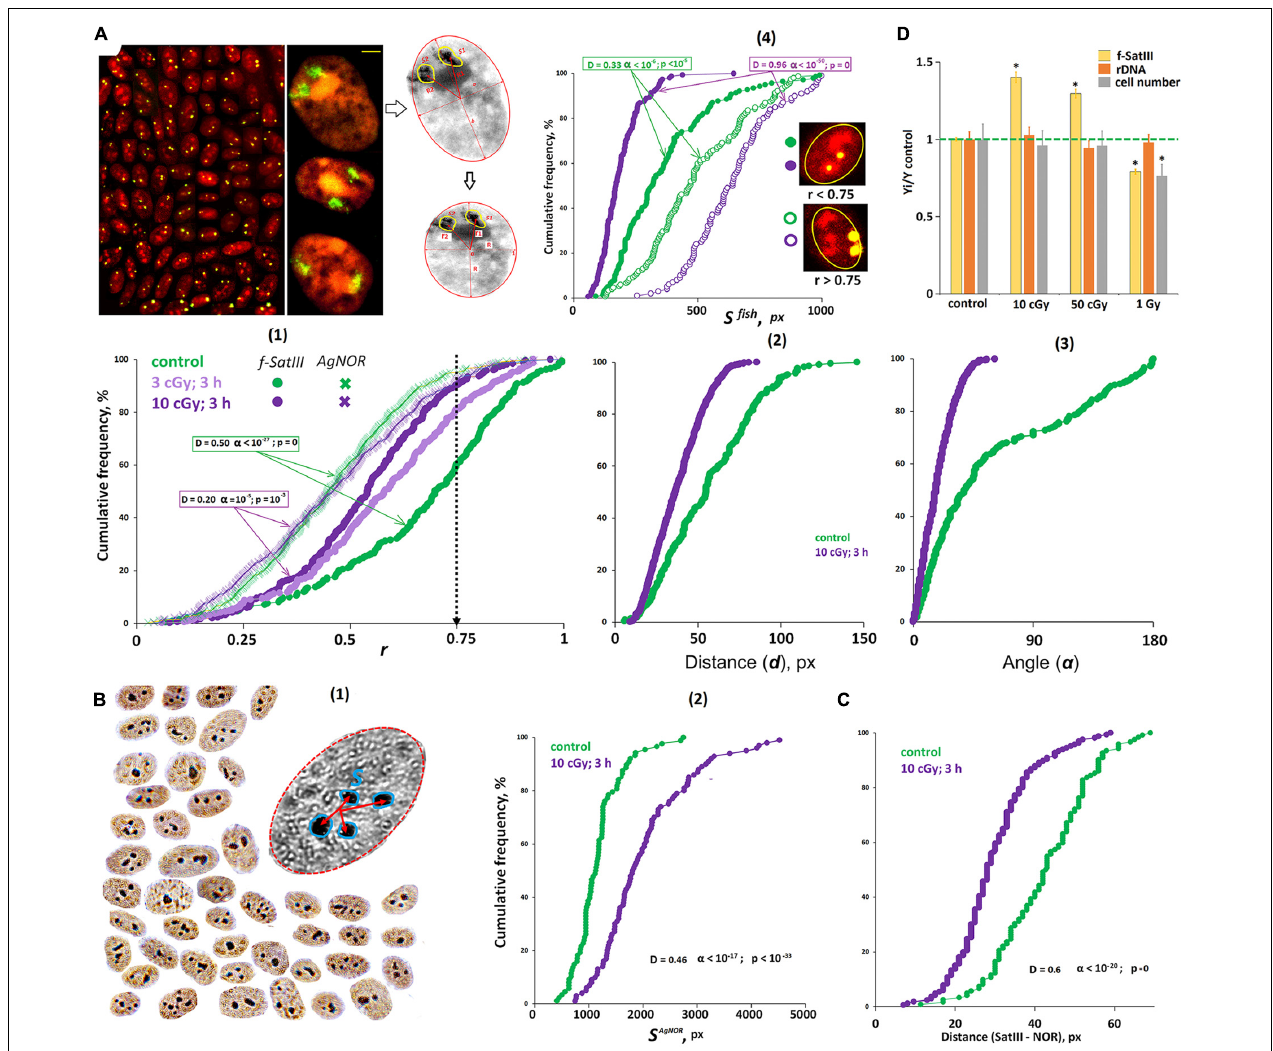
FIGURE 5 | The effect of IR on the localization of 1q12 and nucleolus in MSCs. (A) Foto: The example of the FISH result obtained for the MSCs. 1q12 loci are represented in the nucleus (red, PI) by two fluorescent signals (green). Gallery of the cells was formed from multiple photos. The nucleoli contrast in the nucleus. Bars, 5 µ m. Colorless drawing: Schematic representation of the MSC nucleus after carrying out affine transformations, where r 1 and r 2 are normalized radius vectors of the FISH signals. (1) Cumulative histograms of the frequency distribution of the FISH and Ag signals by the radius vector r (0: center of the nucleus) for intact and irradiated (3 and 10 cGy) cells. (2,3) The distance and angle between the two FISH signals for intact and irradiated (10 cGy) cells. (4) Cumulative histograms of the frequency distribution of the FISH signals by the square S FISH for intact and irradiated (10 cGy) MSCs. Each sample of FISH signals was divided into two fractions: signals with r > 0.75 and r < 0.75. (B) (1) The example of the Ag staining obtained for the MSCs. Gallery of the cells was formed from multiple photos. (2) Cumulative histograms of the frequency distribution of the Ag signals by the total square S AgNOR for intact and irradiated (10 cGy) MSCs. (C) The total distance between the center of the FISH signal and the surface of the nucleolus in the intact and irradiated (10 cGy) MSCs. (D) The effect of MSC irradiation on the content of f-SatIII, rDNA, and cell number. Doses are shown in the figure. Irradiated cells were cultured for 72